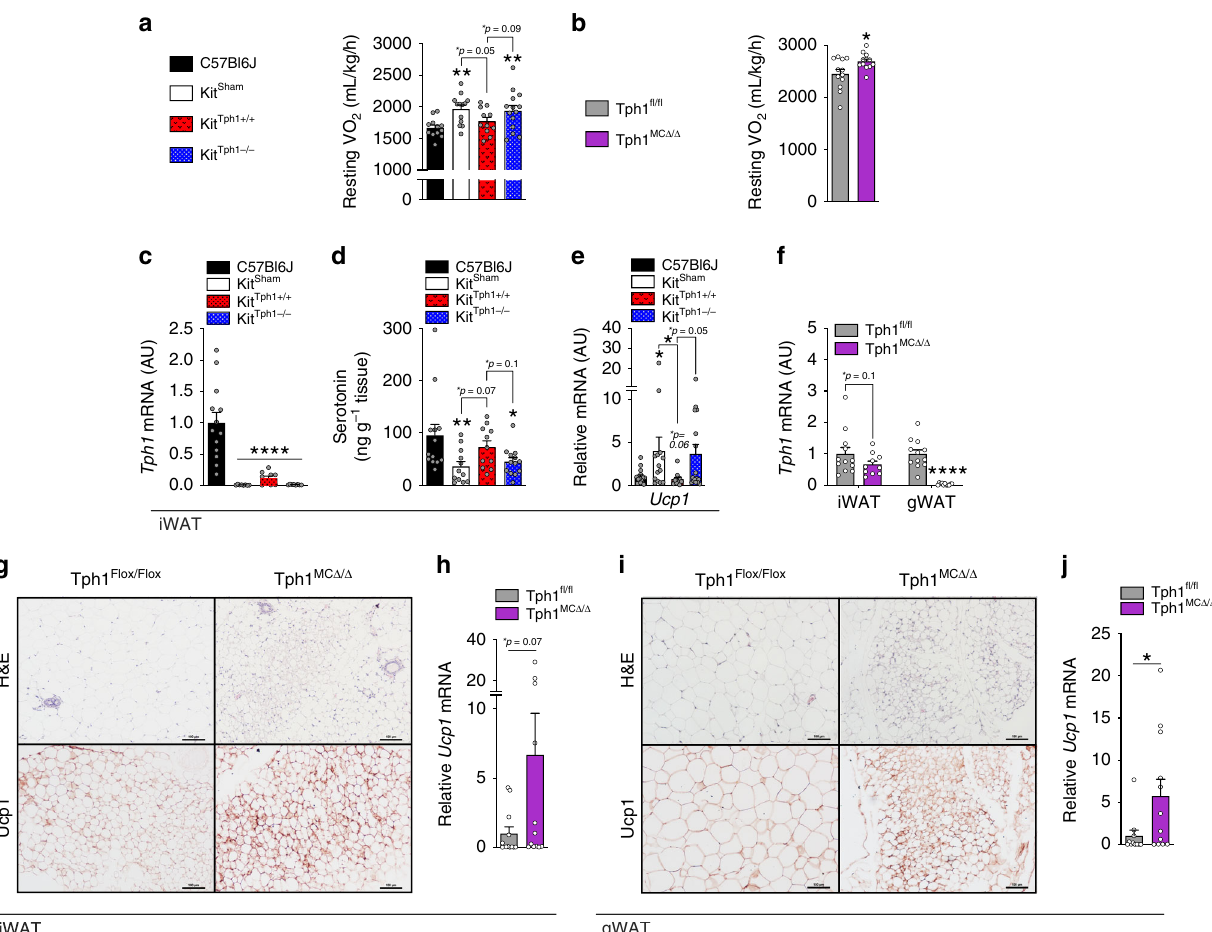
Fig. 4 Genetic removal of mast cell serotonin increases energy expenditure and causes adipose tissue browning. a Resting oxygen consumption of C57BL6J ( n = 12), Kit Sham ( n = 13), Kit Tph + / + ( n = 11) and Kit Tph − / − ( n = 14). b Resting oxygen consumption of Tph1 MCKO mice ( n = 12). c